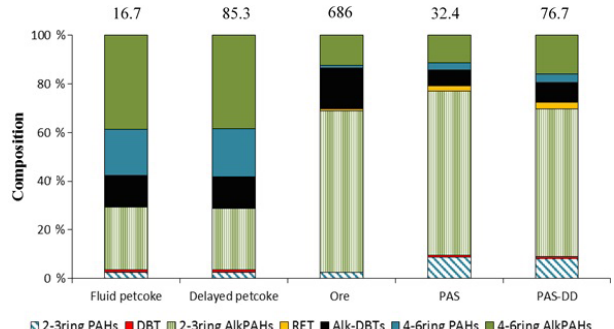
Figure 4. PAC compositions of fluid petcoke, delayed petcoke, oil sands ore, and air samples (PAS and PAS-DD). PAC compositions of air samples are averages of five sites. The number at the top of each bar represents the total residue concentration (ngmg − 1 , dry weight basis) or concentration in air (ngm − 3 ) , for PAS and PAS- DD air